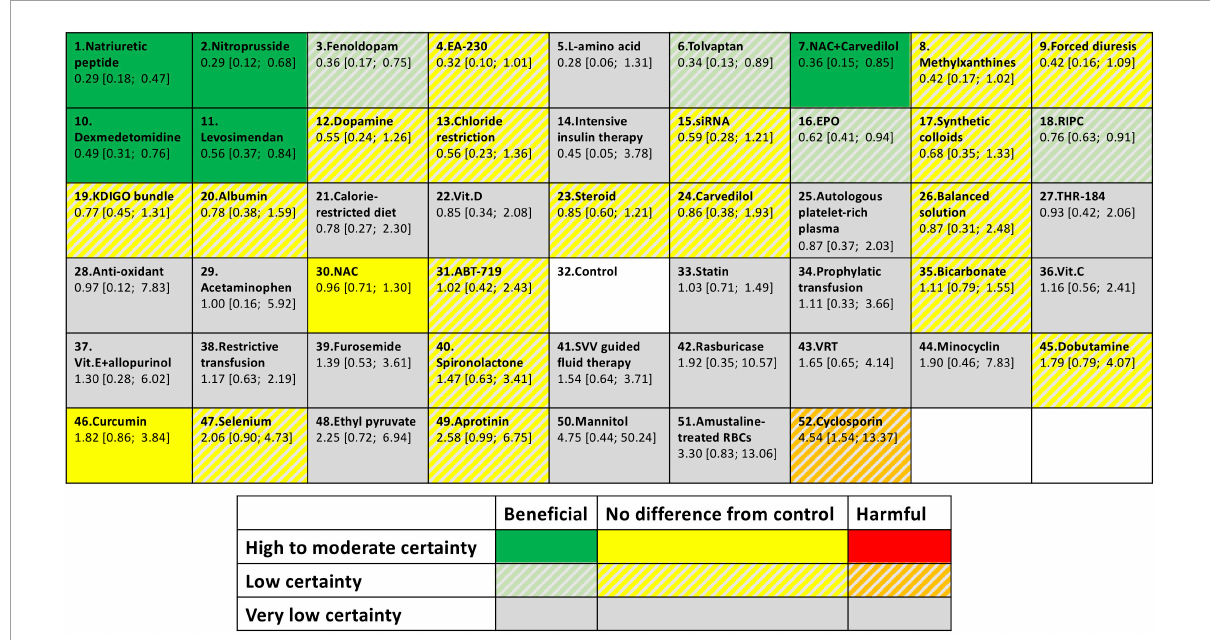
FIGURE5 Summary of finding table for AKI prevention. The colors represent in which category of effectiveness and the certainty of evidence of each intervention. Different interventions were ordered according to P -score. Each box provides rank probability and relative estimate effect for AKI prevention (in comparison with the control